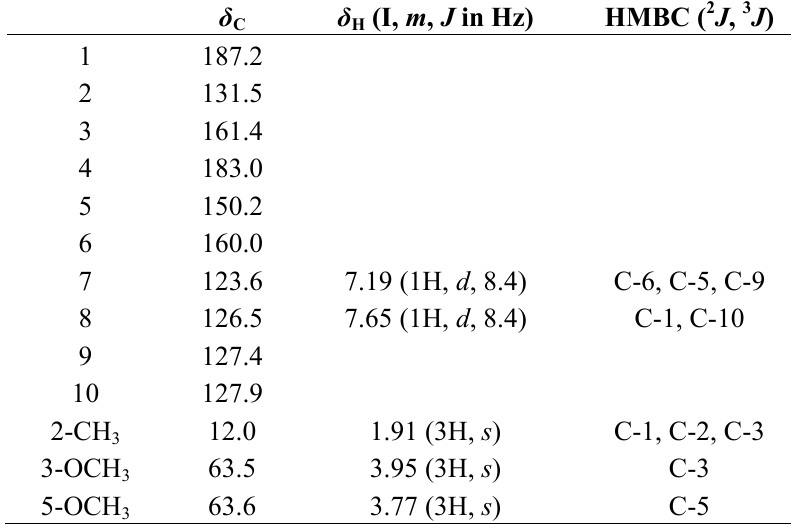
Table 1. NMR data for 6-hydroxy-3,5-dimethoxy-2-methyl-1,4-naphthoquinone ( 1 ) in DMSO- d 6